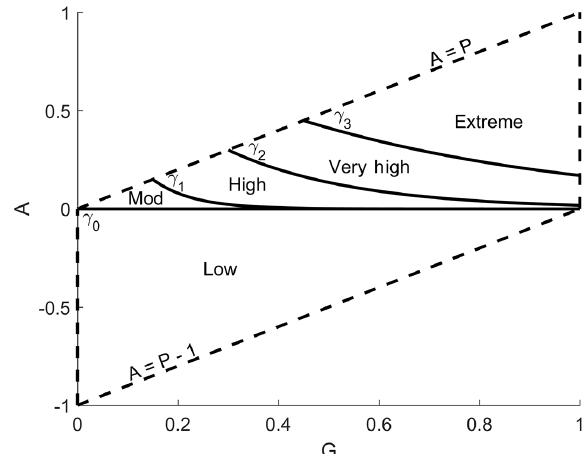
Figure 3. Partitioning of the domain of probability of exceedance, G , versus the respective anomalies, A , into five classes of fire dan- ger: “low”, “moderate”, “high”, “very high” and “extreme”. The partitions are delimited by curves γ 0 , γ 1 , γ 2 and γ 3